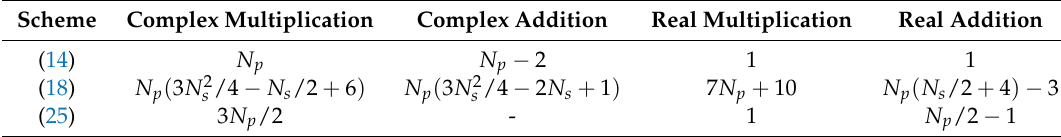
Table 3. Complexity of the conventional and proposed